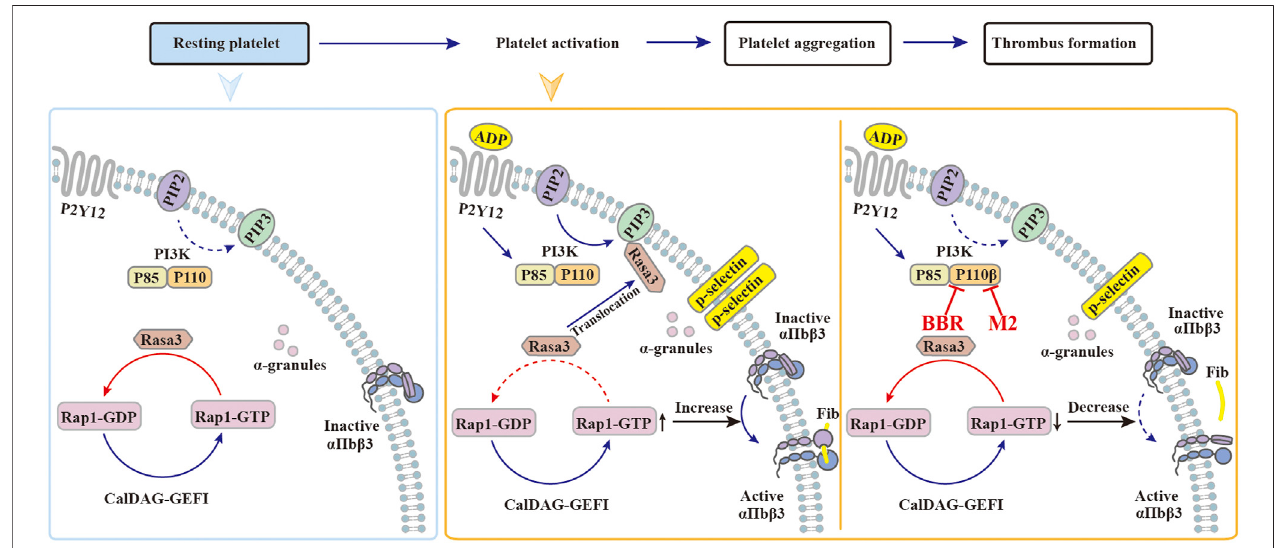
FIGURE 10 | Possible mechanisms of BBR to inhibit platelet activation. (1) In resting platelets, the majority of Rasa3 are located in the cytoplasm, while PI3K and CalDAG-GEFI jointly maintain the balance between GDP-Rap1 and GTP-Rap1. (2) When stimulated by agonists such as ADP, the PI3K signaling pathway is activated, and Rasa3 will translocate from the cytoplasm to the cell membrane, which is recruited by PIP3. As a result, the balance between GDP-Rap1 and GTP-Rap1 is broken, which causes the activation of integrin α IIb β 3 and the platelets. (3) When the platelets are pretreated with BBR or M2, the catalytic activity of class I PI3K p110 β is inhibited.Rasa3willnottranslocatetothecellmembraneandwillremaininthecytoplasm,whichwillhelptomaintainthebalancebetweenGDP-Rap1andGTP-Rap1.In this manner, the integrin α IIb β 3 keeps an inactive form, and the platelet activation is inhibited by BBR or